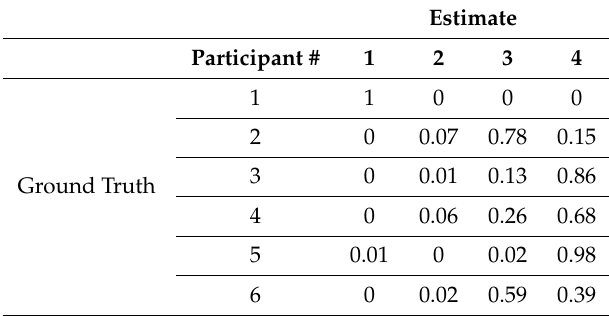
Table 10. Confusion matrix for identification based on an Euclidean distance minimization approach applied to RSS data from the 433 MHz